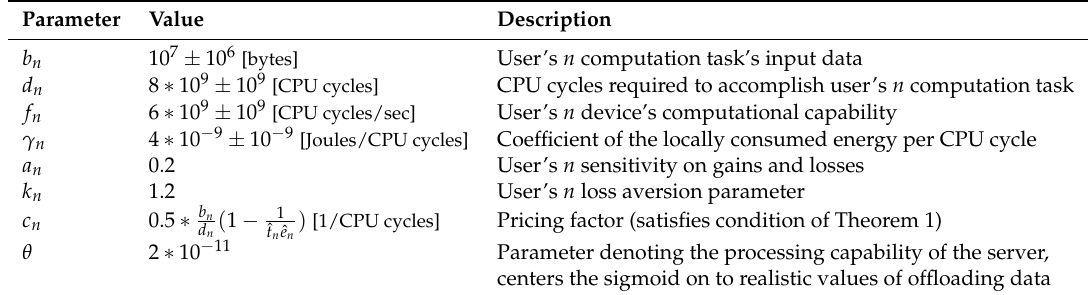
Table 1. Typical values for simulation parameters